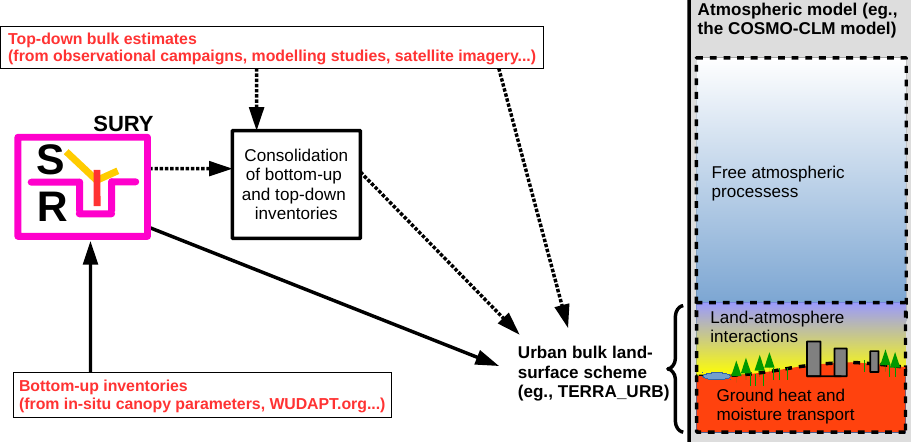
Figure 6. Application outline of the SURY. The main application flow of SURY is indicated with full arrows, whereas optional application flows are indicated with dashed